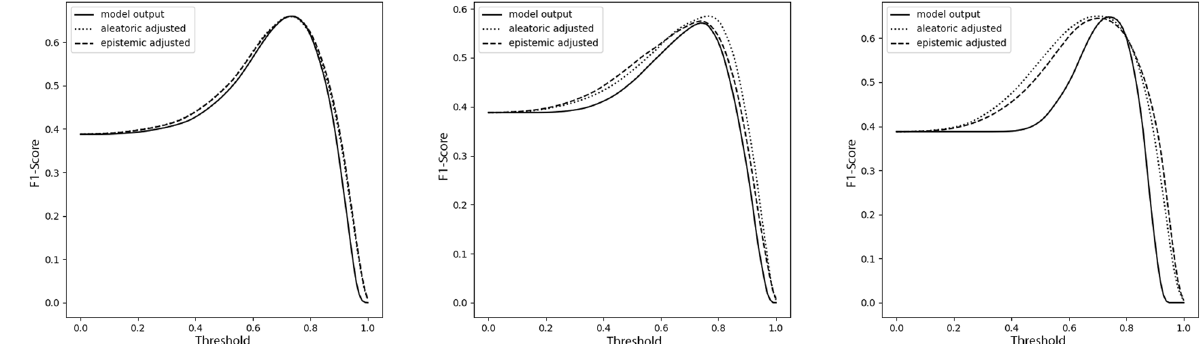
Fig. 14 F1-Score vs. Threshold curves for the novel dataset. Left: variational; middle: Monte-Carlo dropout; right: